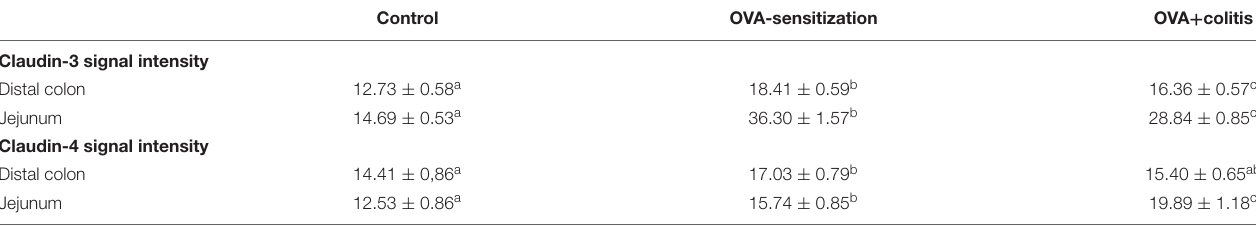
TABLE 5 | Quantification of claudin-3 and claudin-4 expression intensity.